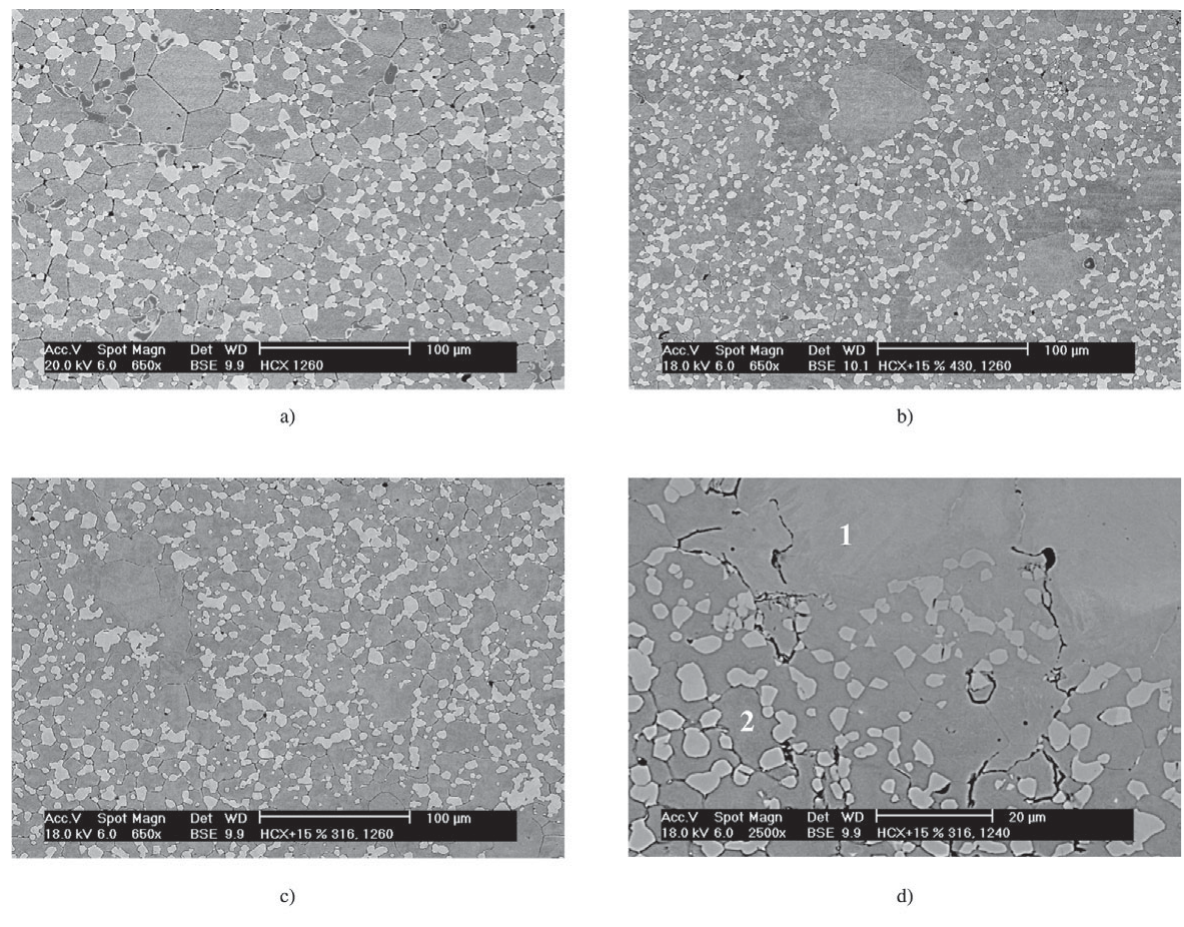
Figure 6. Microstructures (BSE) of several materials sintered in vacuum at 1260 ºC: a) HCx; b) HCx+15 % 430LHC; c) and d) HCx+15 % 316L.